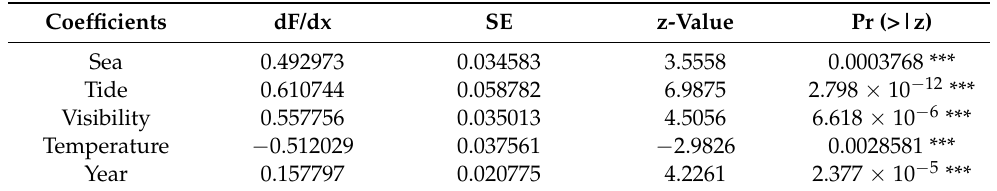
Table 4. Sample marginal effects for each observation unit, given n observations, are accounted for. Here, ‘Coefficients’ refers to the factors within the model; ‘dF/dx’ denotes the partial derivatives displaying the marginal effects of the predictors ( x (cid:48) ) on y i (‘prey’); ‘SE’ stands for standard error; ik ‘z-value’ denotes the test statistic obtained for each predictor; and ‘Pr (>|z|)’ refers to the associated p -value in a two-sided hypothesis test (where the null accounts for non-significance). The significance level is: (***) significance at